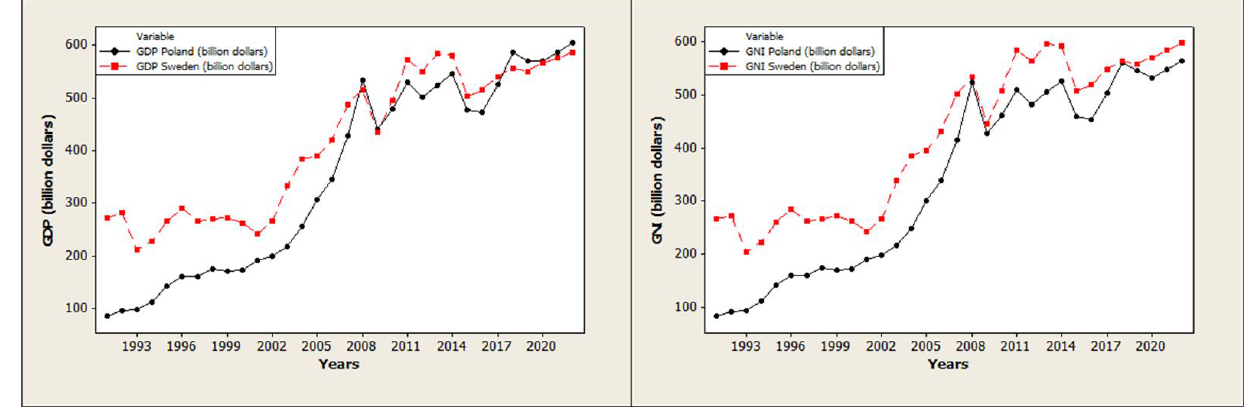
Figure 5. Comparison of GDP vs. GNI for Poland and Sweden between 1991 and 2022.